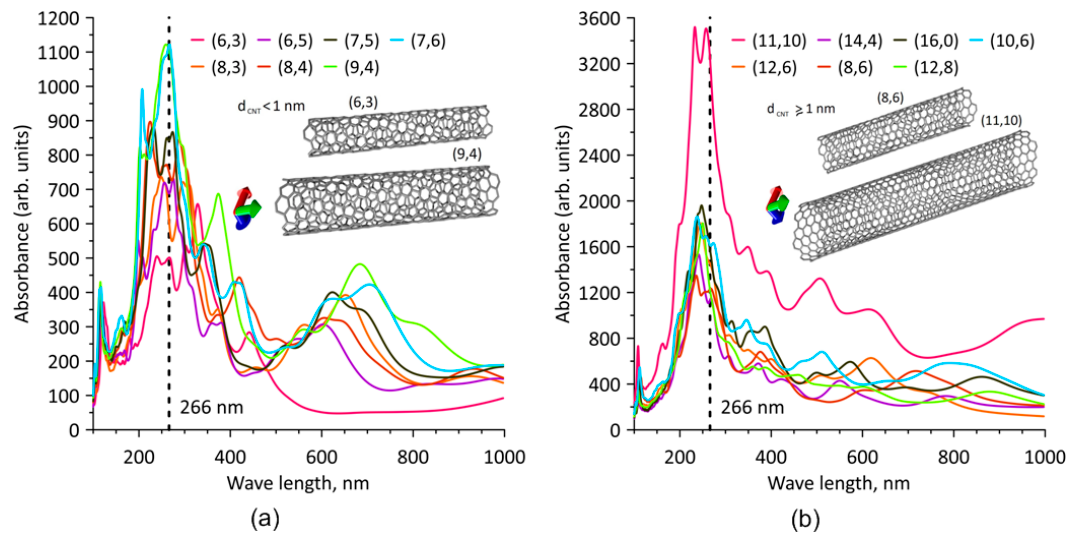
Figure 2. Absorption spectra for nanotubes of ( a ) subnanometer diameter and ( b ) diameters of 1 nm and more.